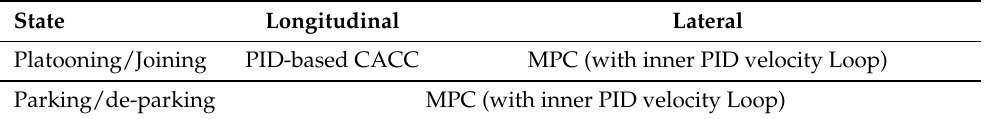
Table 2. Control approach related to each maneuver (CACC stands for Cooperative–Adaptive Cruise